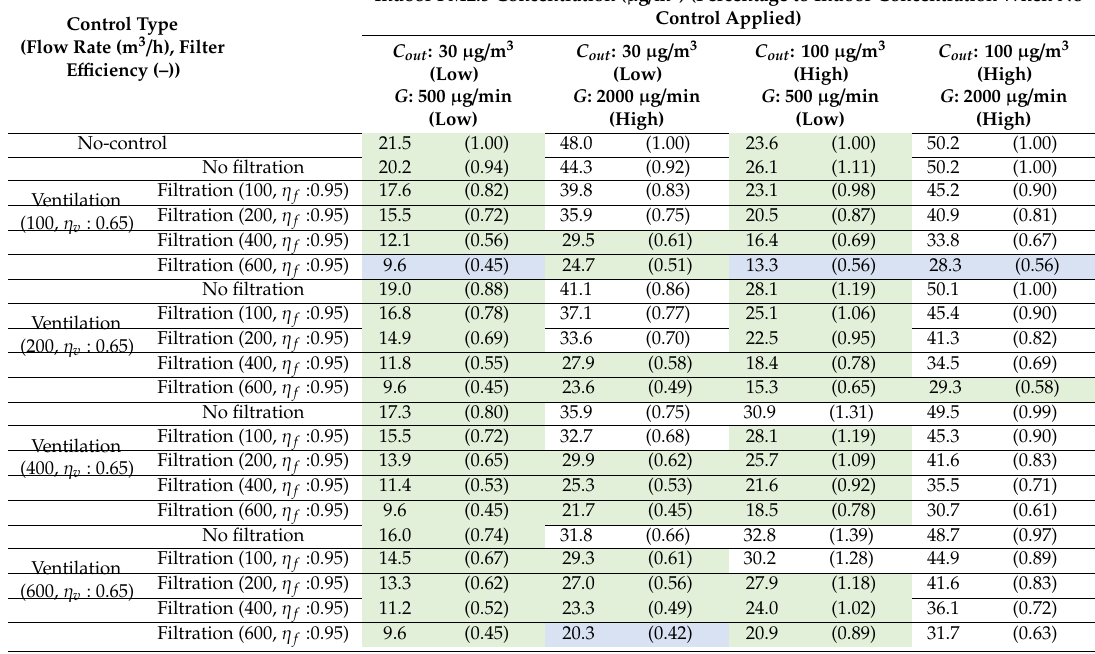
Table 9. Combined operation of ventilation and filtration system e ff ects on indoor PM2.5 concentration depending on outdoor concentration and indoor generation